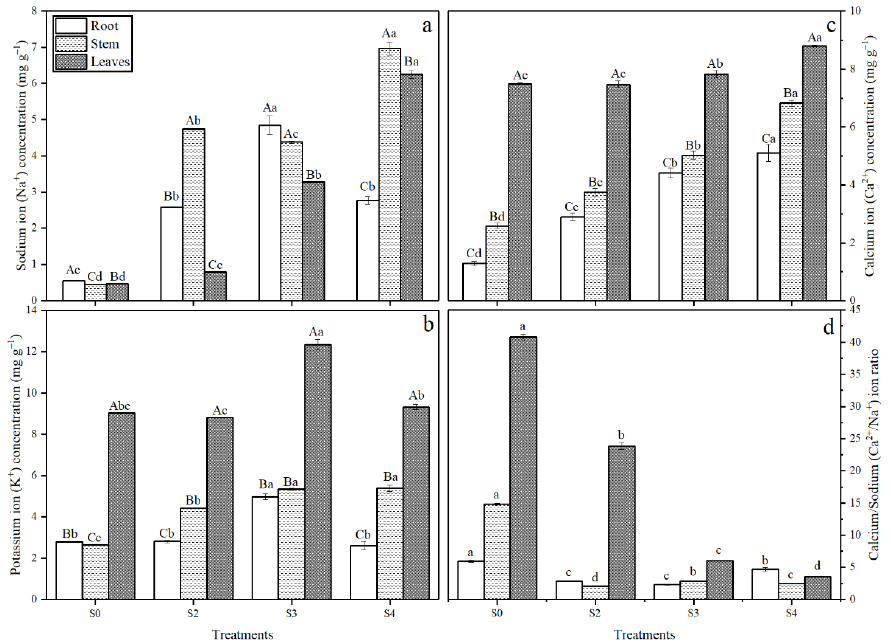
Figure 5. Effects of salinity stress on ( a ) sodium ion (Na + ) concentration, ( b ) potassium ion (K + ) concentration, ( c ) calcium ion (Ca 2+ ) concentration, and ( d ) calcium/sodium (Ca 2+ /Na + ) ion ratio in C. elegans seedlings. S0, S2, S3, and S4 indicate control, 0.2%, 0.3%, and 0.4% salt concentration treatments, respectively. Columns are the mean ± standard error. Lowercase letters denote statistical results among different treatments in the same organ, and uppercase letters denote statistical results among different organs for the same treatment. The same letters indicate no difference by the Duncan’s new multiple range test at 5%